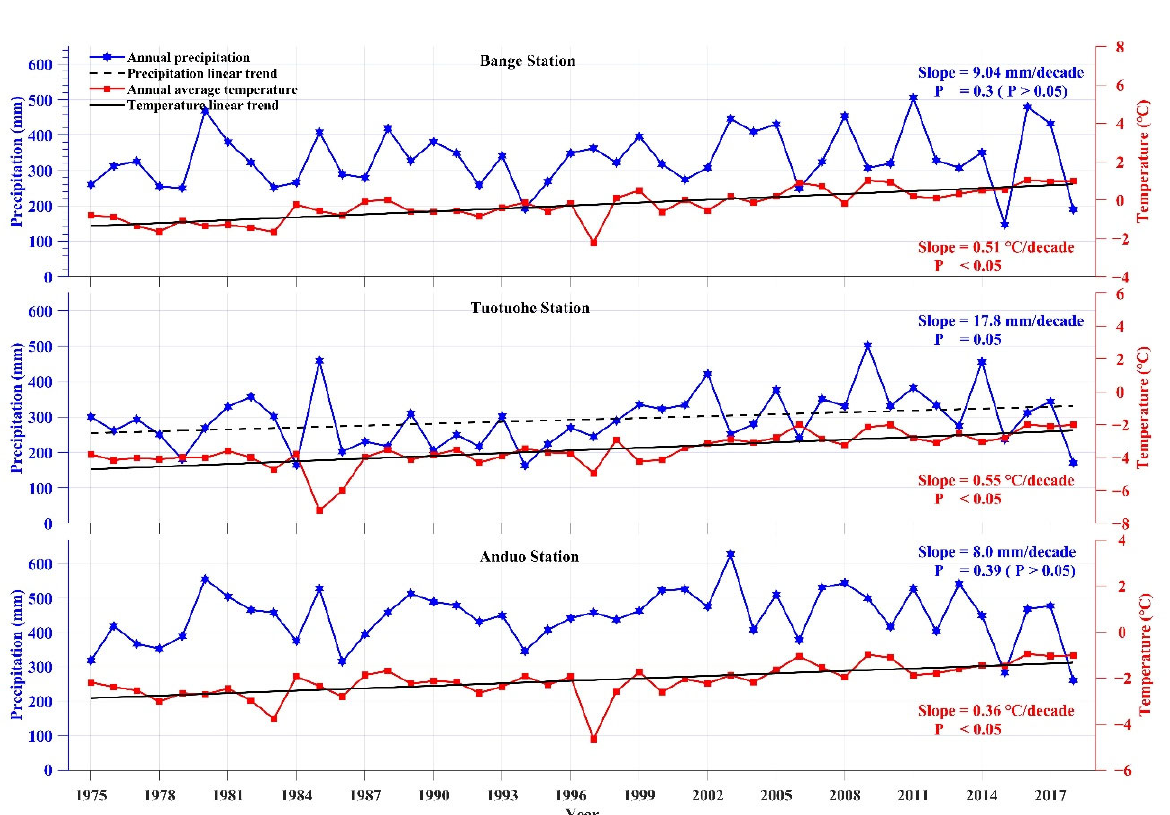
Figure 12. The annual precipitation levels and average temperatures that were recorded by the meteorological stations at Bange, Tuotuohe and Anduo from 1975 to 2018. The black dashed line indicates the linear fitting change in precipitation and the black solid line indicates the linear fitting change in temperature.